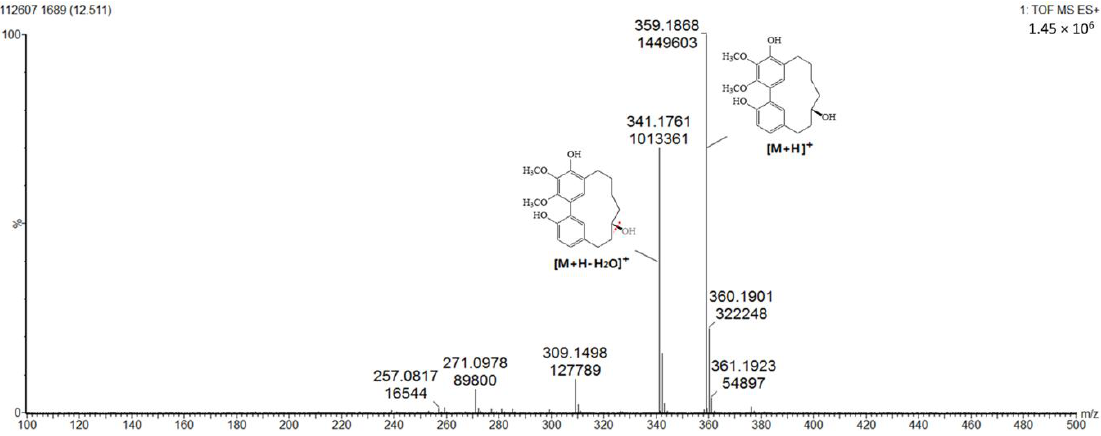
Figure 6. On-line UV – visible spectra of peak 14